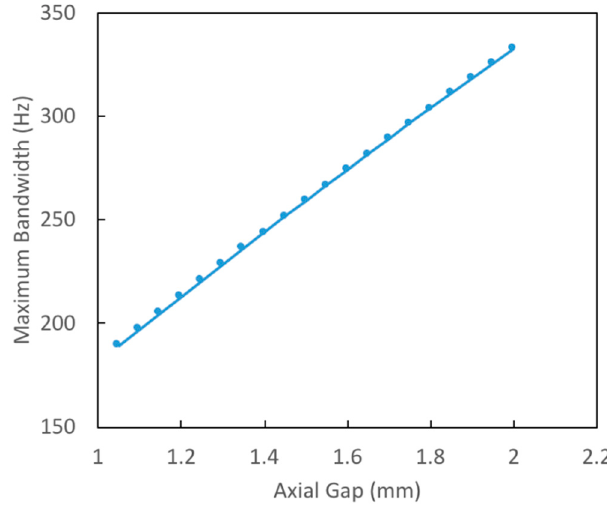
Figure 6. Pareto-optimal curve showing maximum achievable bandwidth as a function of axial gap.